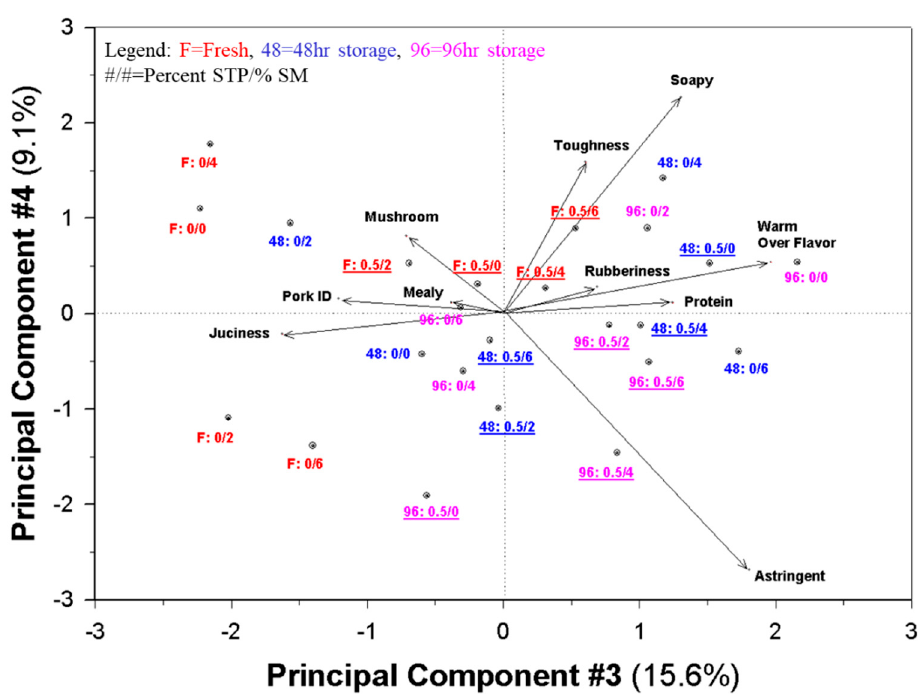
Figure 2. Principal component analysis (PCA) plot relating samples varying in amount of shitake mushroom powder and sodium tripolyphosphate to attribute intensities given by the descriptive panel.